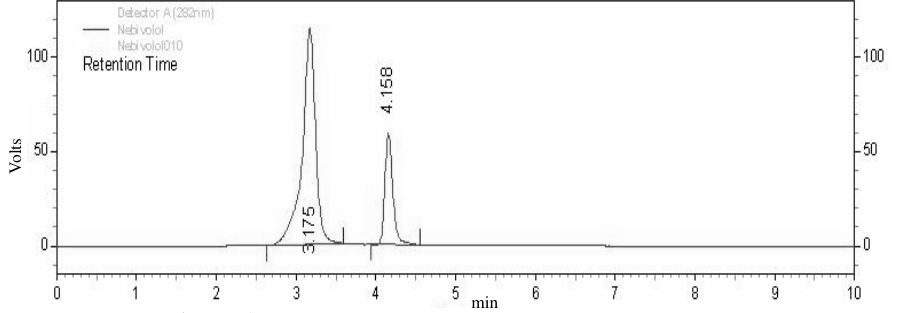
Figure 1. Typical chromatogram of nebivolol by HPLC.